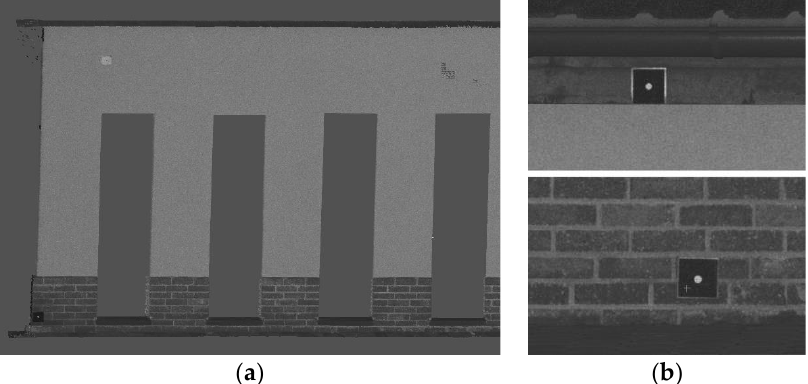
Figure 12. The measurements of sCPs and nChPs on TLS point cloud: ( a ) elevation plane cut from the model for nChPs measurements; ( b ) sCPs visualization on TLS point cloud. Table 6. The analysis of manual measurements of sCPs and nChPs on TLS point cloud. RMSE X RMSE target measurements were divided into two groups with elevation two and without. Con- values on sCPs and nChPs (excluding E2) are acceptable for geometric analysis purposes.